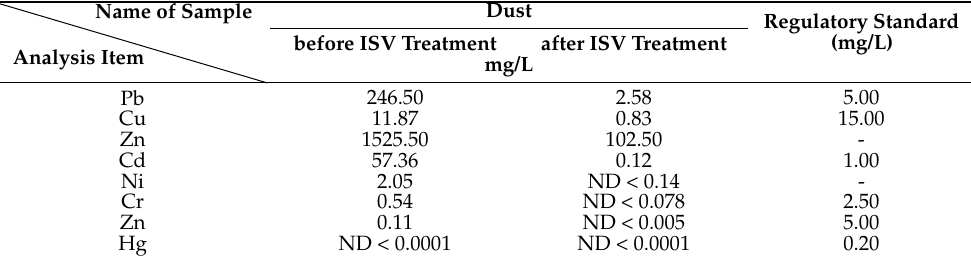
Table 2. TCLP results of the dust before and after ISV treatment.